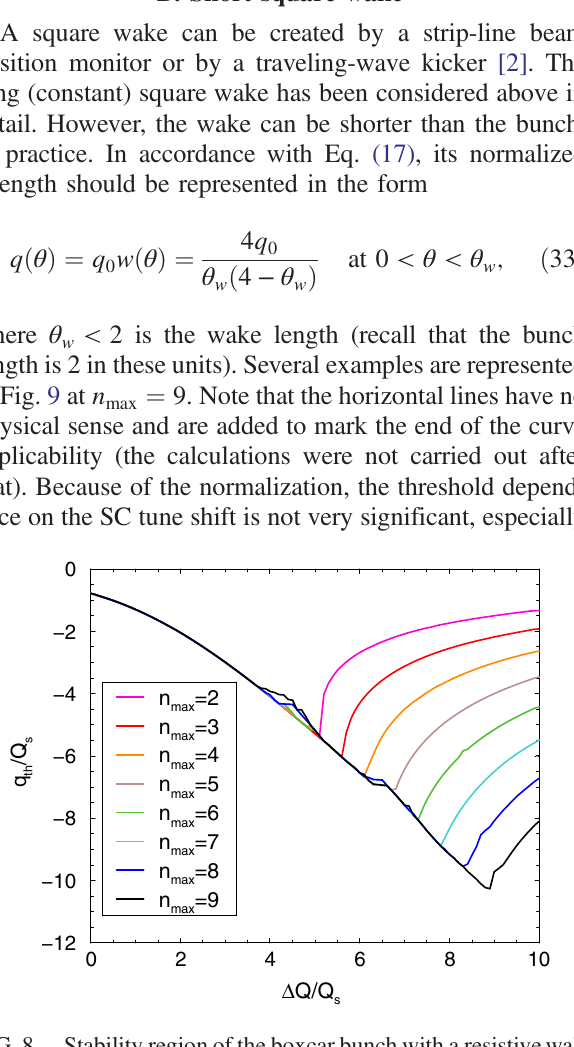
FIG. 8. Stability region of the boxcar bunch with a resistive wall wake. The normalized magnitude of the wake is given by Eq. (32), and index n means maximal power of the Legendre max polynomial in the expansion. The left-hand line shows the TMCI threshold, and the right-hand (rising) curves